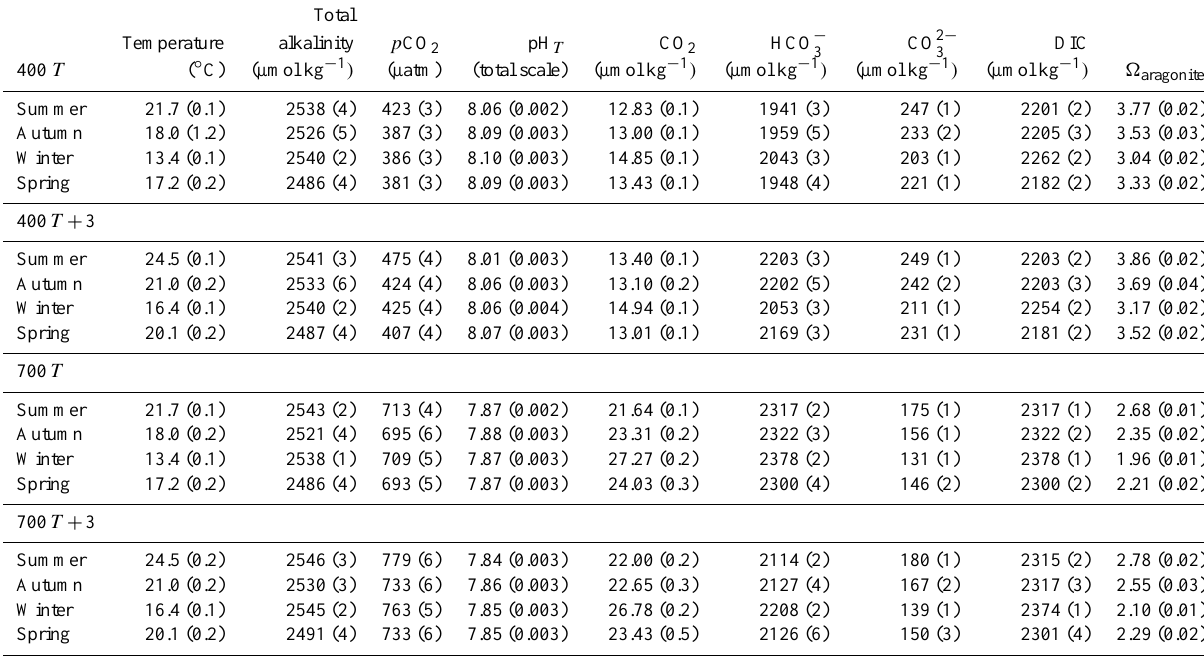
Table 1. Mean values of parameters of the carbonate chemistry for each treatment of p CO 2 (400 and 700µatm) and temperature treatment ( T , T + 3 ◦ C) and season. Data are mean ± s.e.m. (in bracket), n =9–12 for TA and n =35–55 for the other measurements. Salinity ranged from 37.9 to 38.3. Total alkalinity in the Bay of Villefranche measured from January 2007 to December 2008 was 2545 ± 15µmolkg − 1 at the surface and 2546 ± 10µmolkg − 1 at 50m depth (J.-P. Gattuso, unpubl.